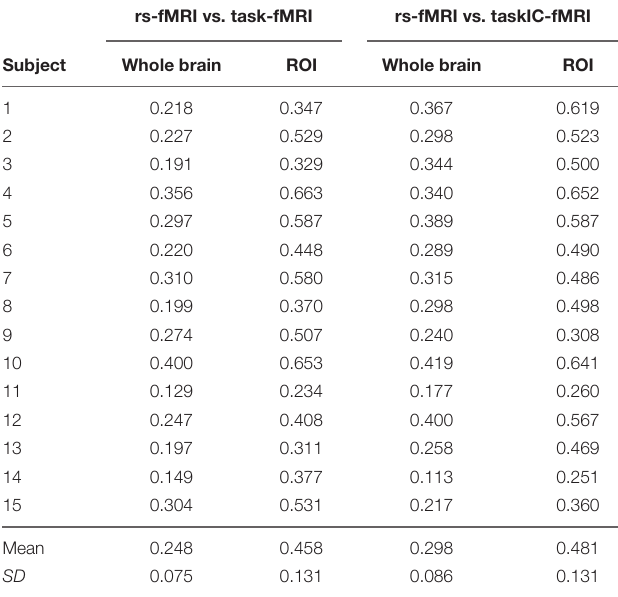
TABLE 2 | Dice coefficients between resting-state and task-based Maps (task-fMRI and taskIC-fMRI) for the whole-brain and within language regions-of-interest (ROI), for each